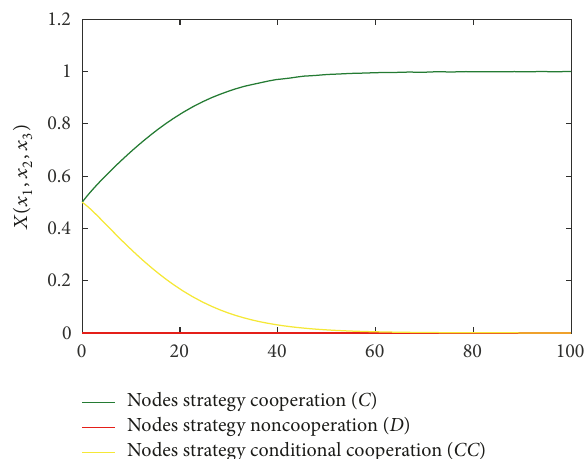
Figure 5: The state of population when 𝑥 = (0.5, 0, 0.5).